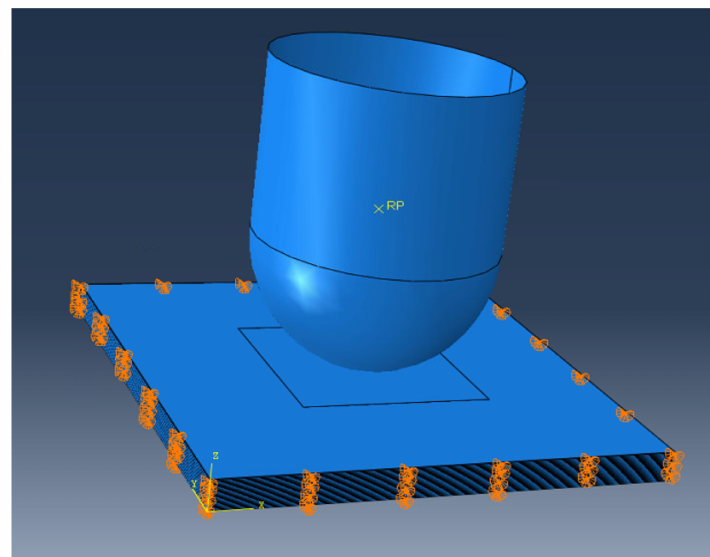
Figure 4. FE model of the composite plate impact.